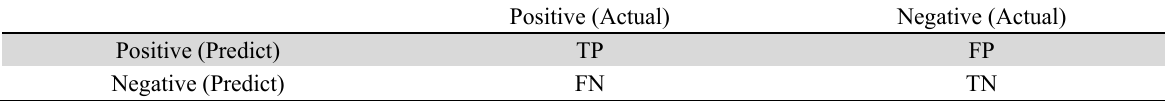
Confusion Matrix